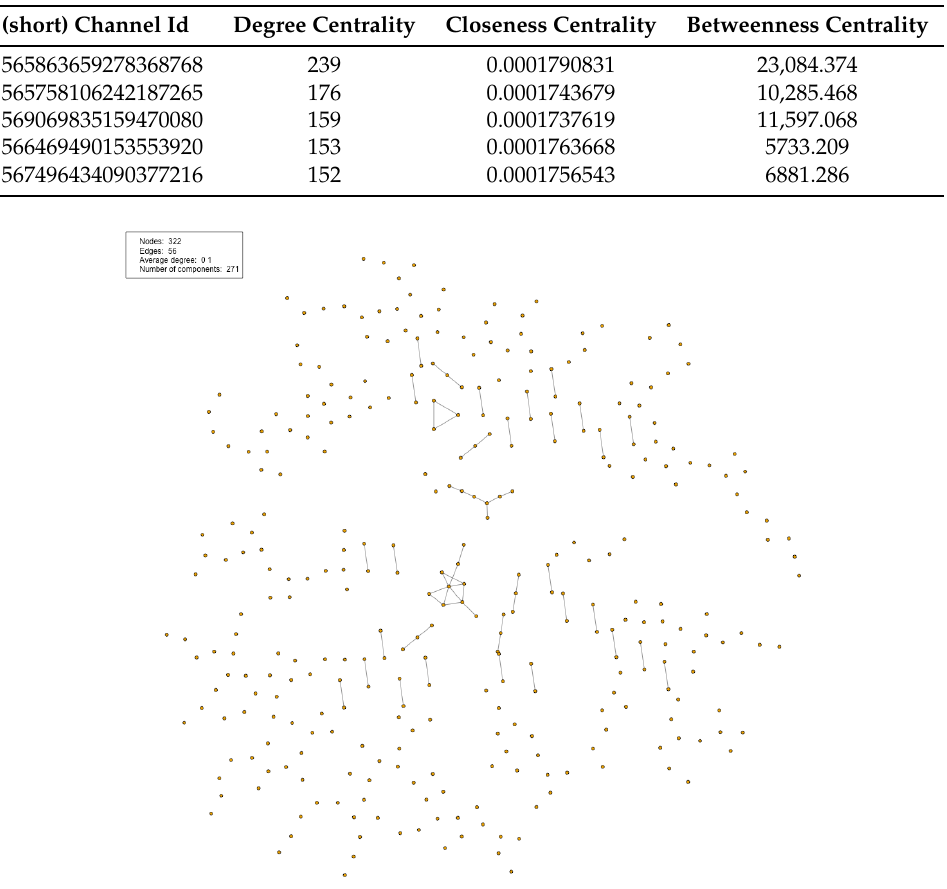
Figure 19. Channel network from the blockchain, mainnet, first